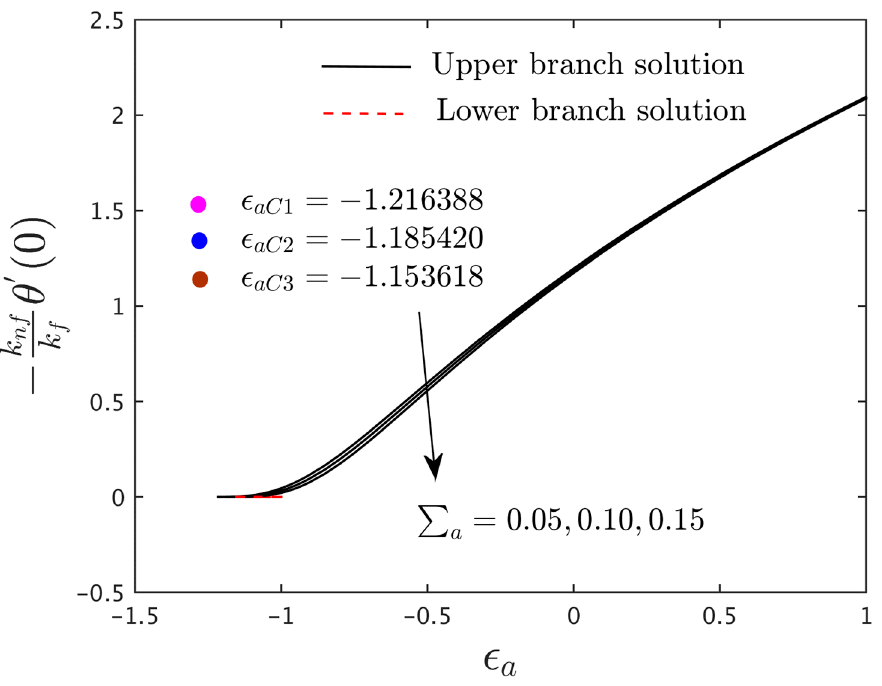
ε for the numerous values of a